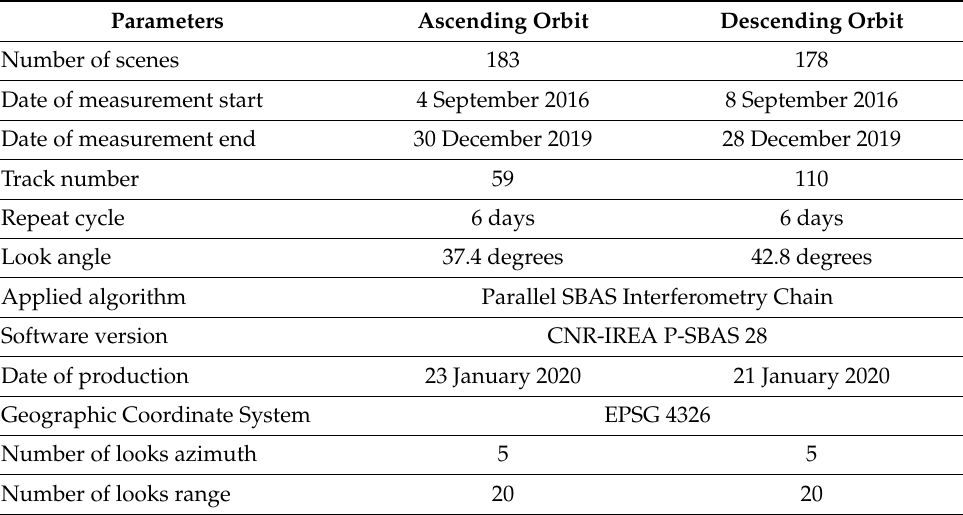
Figure 1. Map of the Chaingy experimental site. ( a ) Regional setting in France (Map data: Google, Landsat/Copernicus, SIO, NOAA, US Navy, NGA, and GEBCO) that contains modified Copernicus Sentinel data (2016) and a ~25 km cell of the EASE equal-area grid used by the SMOS satellite (black rectangle). ( b ) Simplified superficial geology of the studied zone modified from the BRGM geological map of France at the 1:50,000 scale showing the P-SBAS grid (black circles) and the location of the studied zone (red filled polygon). ( c ) Local setting (Map data: Google, Landsat/Copernicus, SIO, NOAA, US Navy, NGA, and GEBCO) of the studied zone (red polygon) showing two extensometers (EXT1 and EXT2) (red placemarks), three soil moistures sensors at E1, E5, and W5 (blue placemarks), three electric profiles (green lines), two core sampling SC1 and SC2 (white polygons), and two P-SBAS grid cells (white and black rectangle) around two grid points West Point WP and East Point EP (white circle). Maps ( a – c ) were created using Google Earth Pro and map b by QGIS (Version 3.4.14, Bern and Chur, Switzerland, http://qgis.org, accessed on 23 September 2021). Table 1. Sentinel-1A/1B GEP InSAR processing